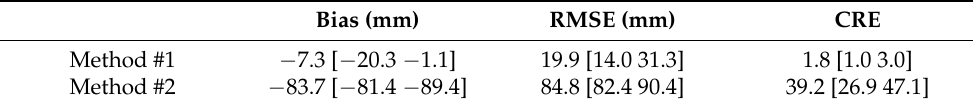
Table 3. Summary of the performance evaluation for the two methods in rainy